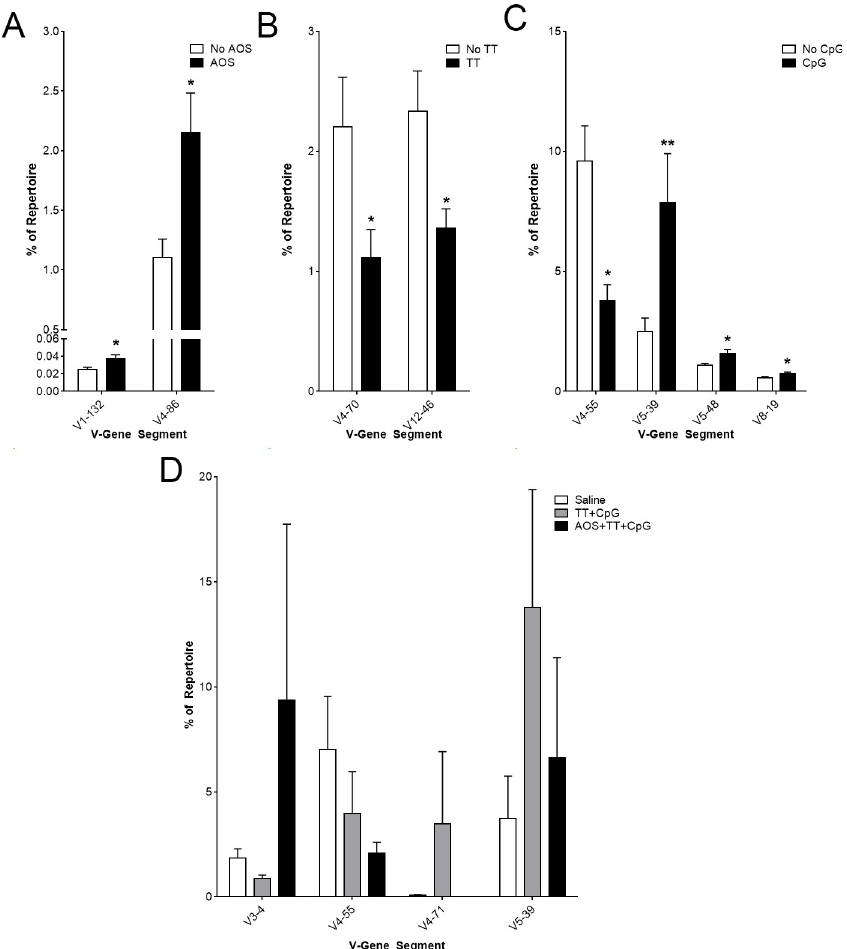
Fig 6. Impact of AOS, tetanus toxoid, and CpG on Splenic B cell V κ -gene segment usage. Mice subjected to one or more treatment variables: Significantly different V-gene segment usage by main effect for AOS (A), TT (B), and CpG (C). (D) Significantly different V-gene segment usage and high frequency V-gene segment usage in saline, TT+CpG, and AOS+TT+CpG treatment groups. � = P < 0.05, �� = P < 0.01, ��� = P < 0.001.